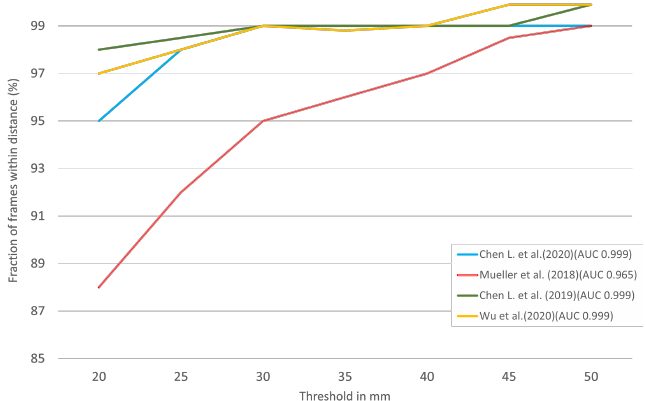
Figure 8. Comparison of [33–35,38] approaches for 3D pose estimation on the STB dataset. The fraction of frames over different maximum Euclidean distance error threshold. The larger area under the curve (AUC) represents better results. (Best viewed on